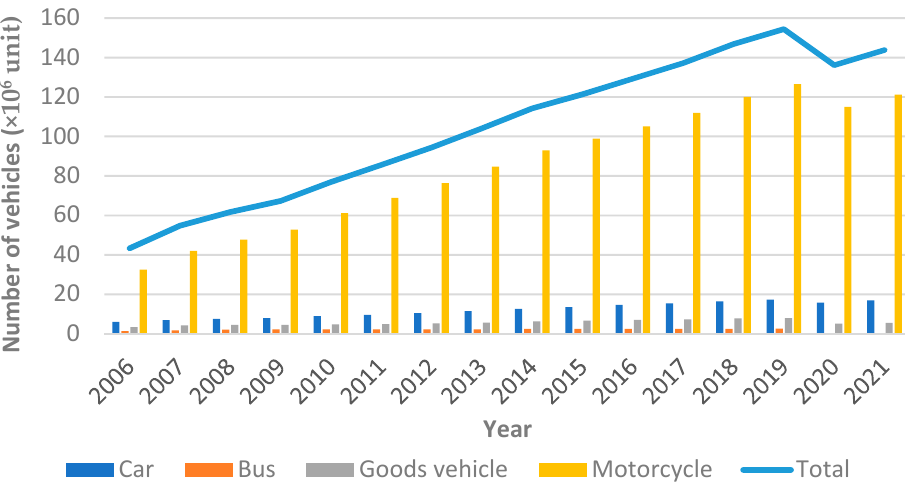
Figure 2. The market size of automotive in Indonesia.